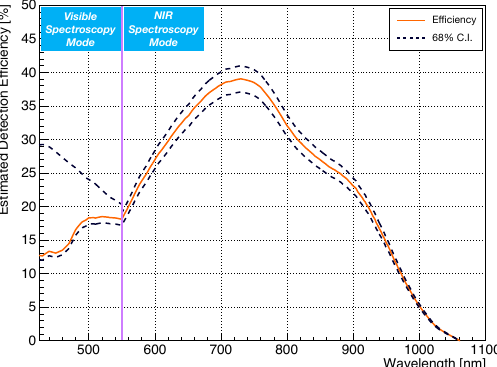
Figure 2. Estimated detection transmission efficiency of the TRIUMF apparatus as a function of the photon wavelength. The 68% Confidence Interval (C. I.) error bands account for systematic uncertainty in the lamp calibration. Below 550 nm, the error increases due to a disagreement between the observed IntelliCal ® LED based light source spectrum and its expected spectrum obtained combining the different hardware transmission specifications of the